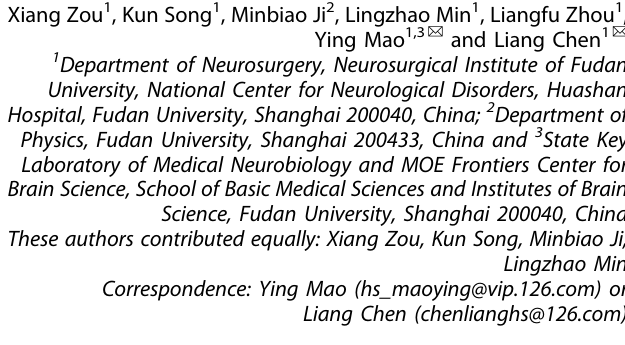
DATA AVAILABILITY All data are available from the corresponding author on reasonable